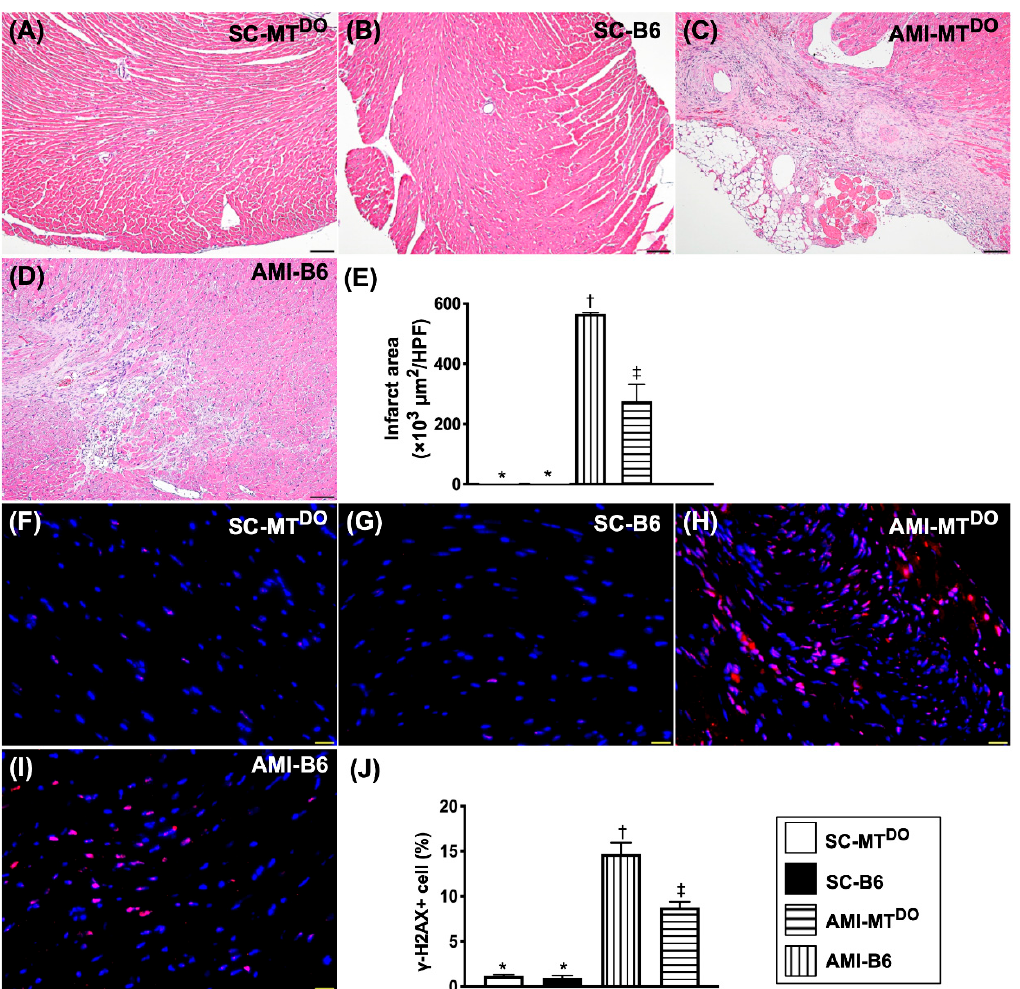
Figure 7. Infarct area and cellular level of DNA damage biomarkers in LV myocardium by 60 days after the AMI procedure. ( A–D ) The microscopic findings (100×) of H.E stain for identification of infarct areas. ( E ) Analytical result of infarct area * vs. other groups with di ff erent symbols (†, ‡), p < 0.0001. The scale bars in the right lower corner represent 100 μ m. ( F–I ) The immunofluorescent (IF) microscopic findings (400×) for identification of positively-stained γ -H2AX+ cells (red color). ( J ) Analytical result of the number of γ -H2AX+ cells. The scale bars in the right lower corner represent 20 µ m. All statistical analyses were performed by one-way ANOVA, followed by Bonferroni multiple comparison post hoc test ( n = 6 for each group). Symbols (*, † , ‡ ) indicate significance (at 0.05 level). SC = sham-operated control; MT DO = double knock out of matrix metalloproteinase (MMP)-9 and tissue plasminogen (tPA) in mice; B6 (i.e., wild type) = C57BL / 6 mice. LV = left ventricular; AMI = acute myocardial infarction.